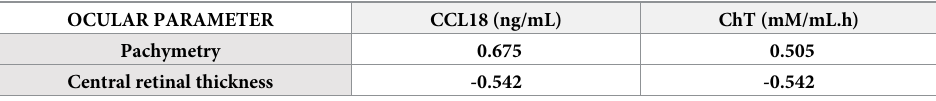
Table 6. Correlation coefficient (r) between ocular parameters and biomarkers’ activity. (p < 0.05) [Weak correla- tion (0.20–0.39); Moderate correlation (0.40–0.69); Strong correlation